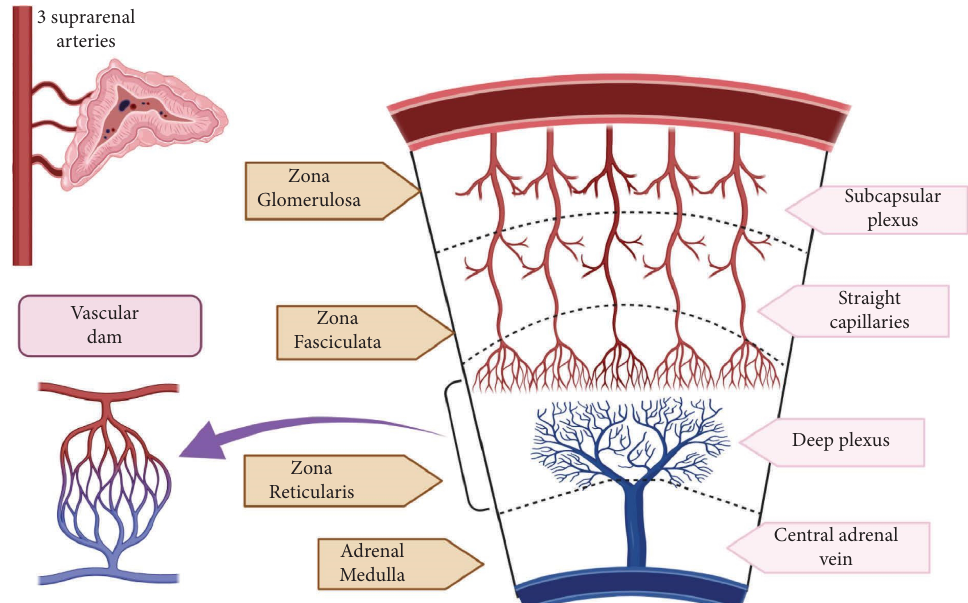
Figure 2: Adrenal gland circulation illustrating the abrupt transition from multiple arteries into capillary plexus, forming the “vascular dam” that increases risk of thrombotic hemorrhagic